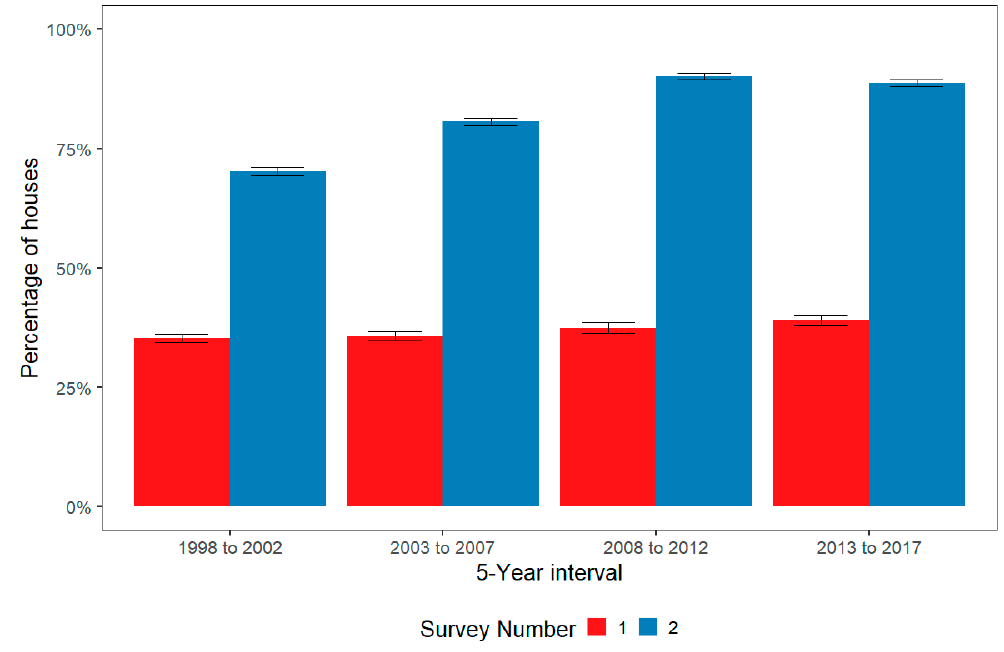
Figure 2. Average Percentage of houses with Critical Healthy Living Priorities fully met at Survey-Fix 1 and Survey–Fix 2 for all NSW projects 1998–2017 by 5-year intervals.